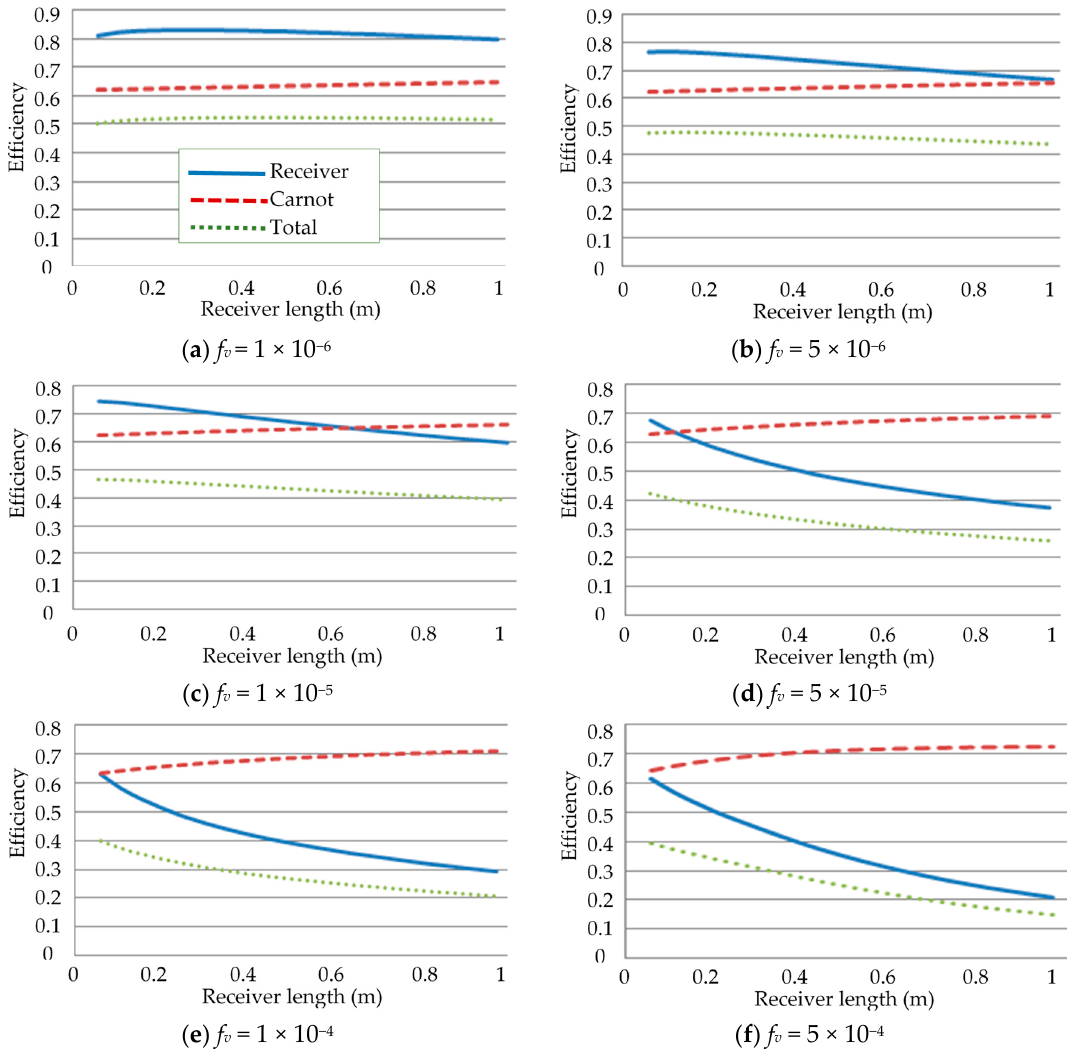
Figure 12. Effect of volume fraction ( f v ) on the efficiencies. Figure 12. E ff ect of volume fraction ( f v ) on the e ffi